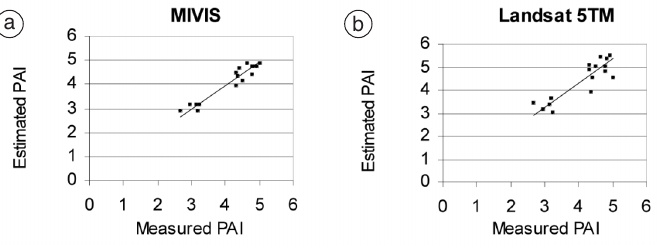
Fig. 8a,b. Linear relationships between PAI measured in the field and PAI estimated by a) MIVIS and b) TM remotely sensed data. The coefficient of determination ( R 2 ) is equal to a) 0.91 for MIVIS data ( y = 0.9872 x ); and b) 0.77 for TM data ( y = 1.0711 x ).